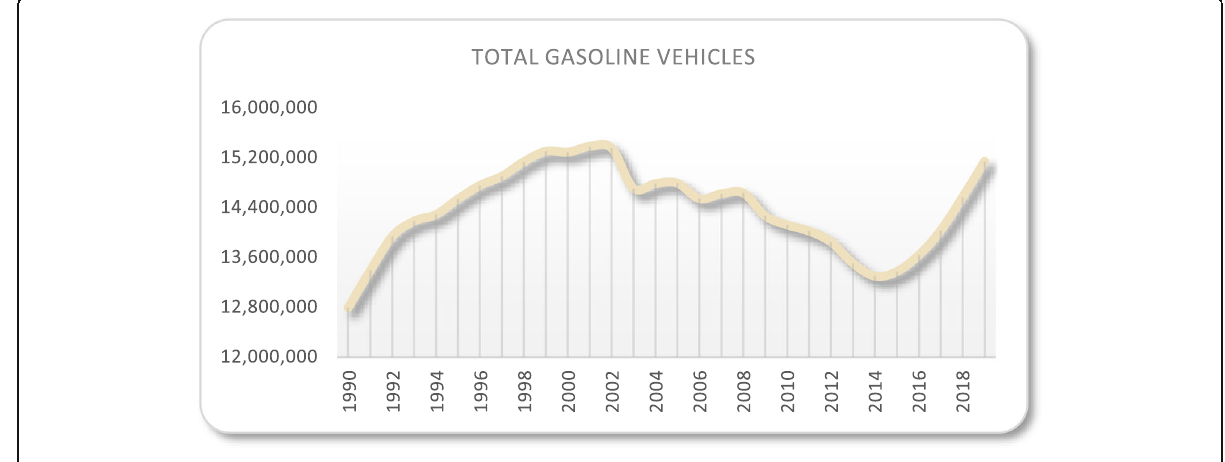
Fig. 18 Total gasoline vehicles fleet in Spain (2019 data)